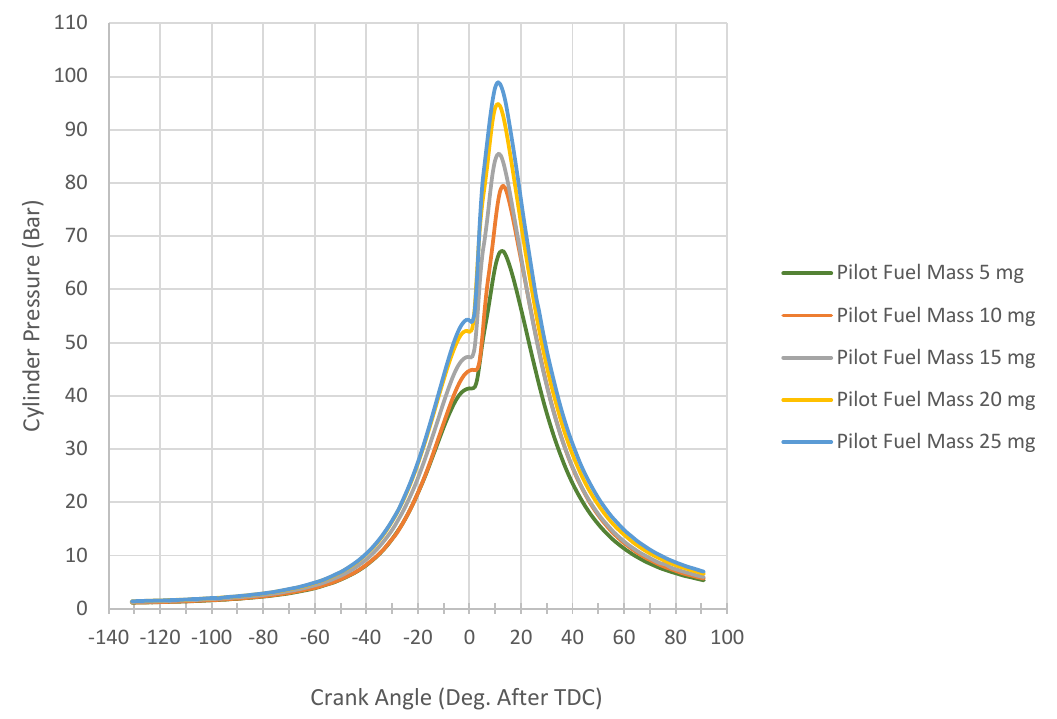
Figure 3. Cylinder pressure versus crank angle (Start of pilot fuel injection (SOI) = 10° BTDC). TDC, top dead center.